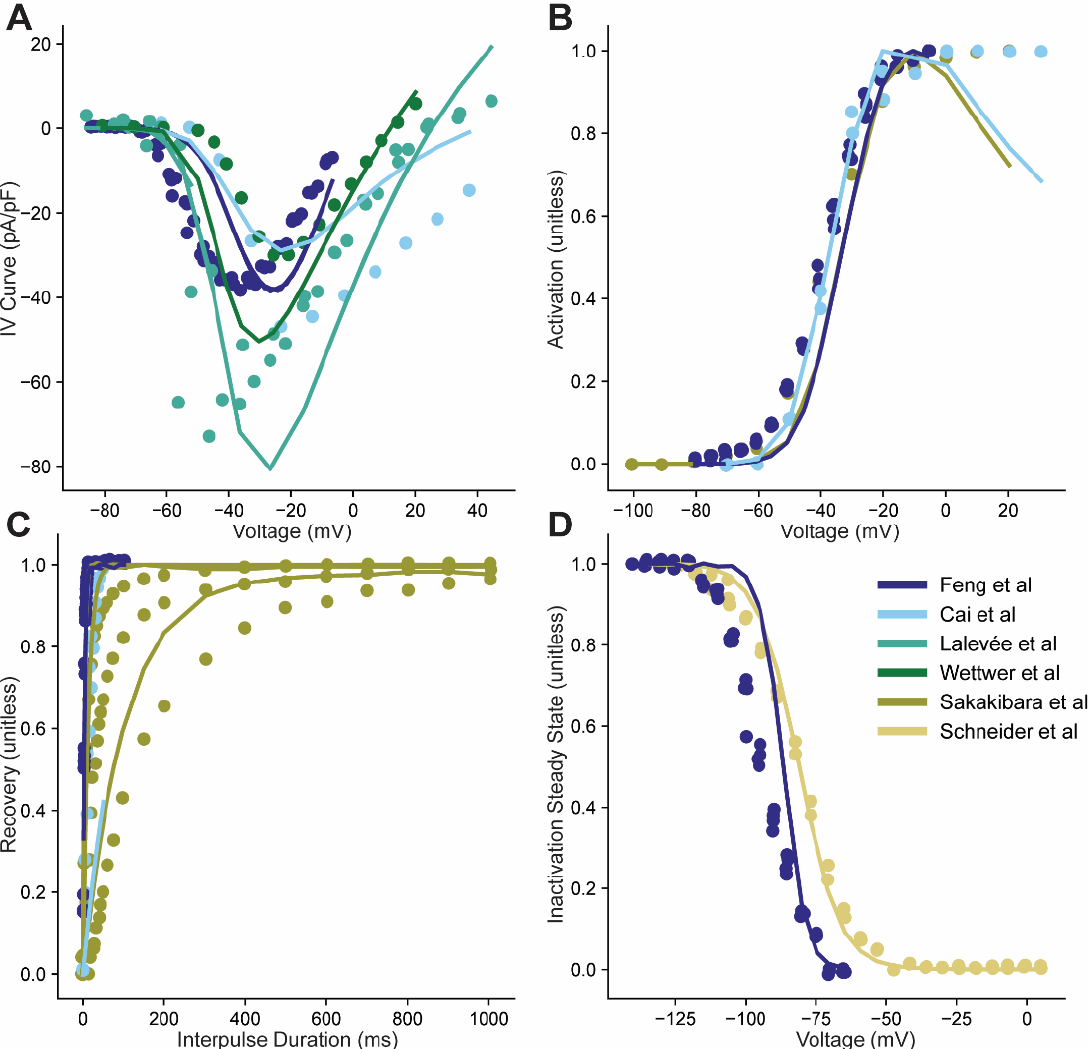
Figure 4. Simulated results of overall model fits to specific xperiments. ( A – D ). Current Voltage relations, steady-state activation, recovery from inactivation, and steady-state inactivation curves using a single set of fit model parameters with experiment-specific temperature and sodium concentrations reported for each study. Experimental data is the same as in Figure 3 from Feng et al., Cai et al., Lalev é e et al., Wettwer et al., Sakakibara et al. and Schneider et al. [33–38]. Data from different experiments taken from the same paper are indicated with a single color indicated in the legend (same for corresponding simulation results). In the event that a different experimental protocol was used to measure the same property (e.g., recovery from inactivation) multiple simulation results are indicated with the same color corresponding to results using the same model parameters but different